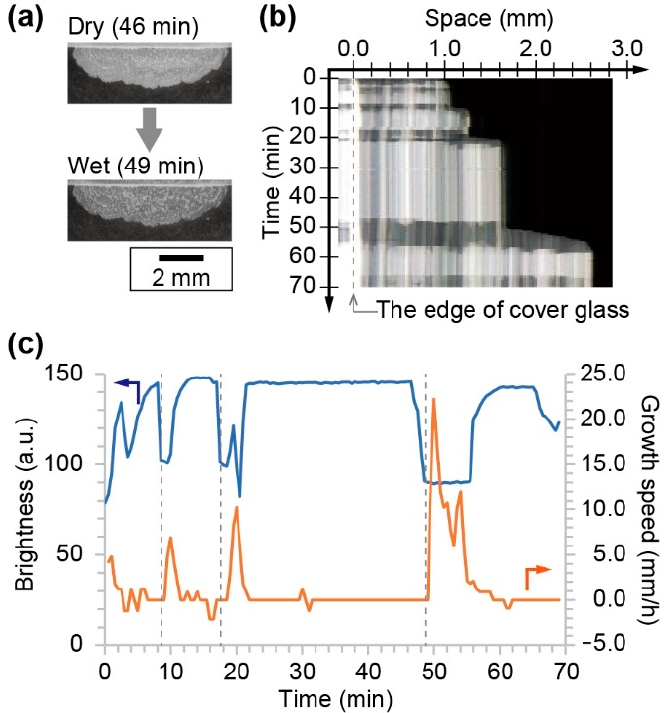
Figure 3. Observation results of flat source system. ( a ) Snapshots of dry and wet crystals. ( b ) Space– time diagram of crystal growth. ( c ) Time series of local brightness and growth speed of NaCl crystal. Blue and orange solid lines indicate brightness and growth speed, respectively. Broken lines indicate the timing of wetting the crystal.